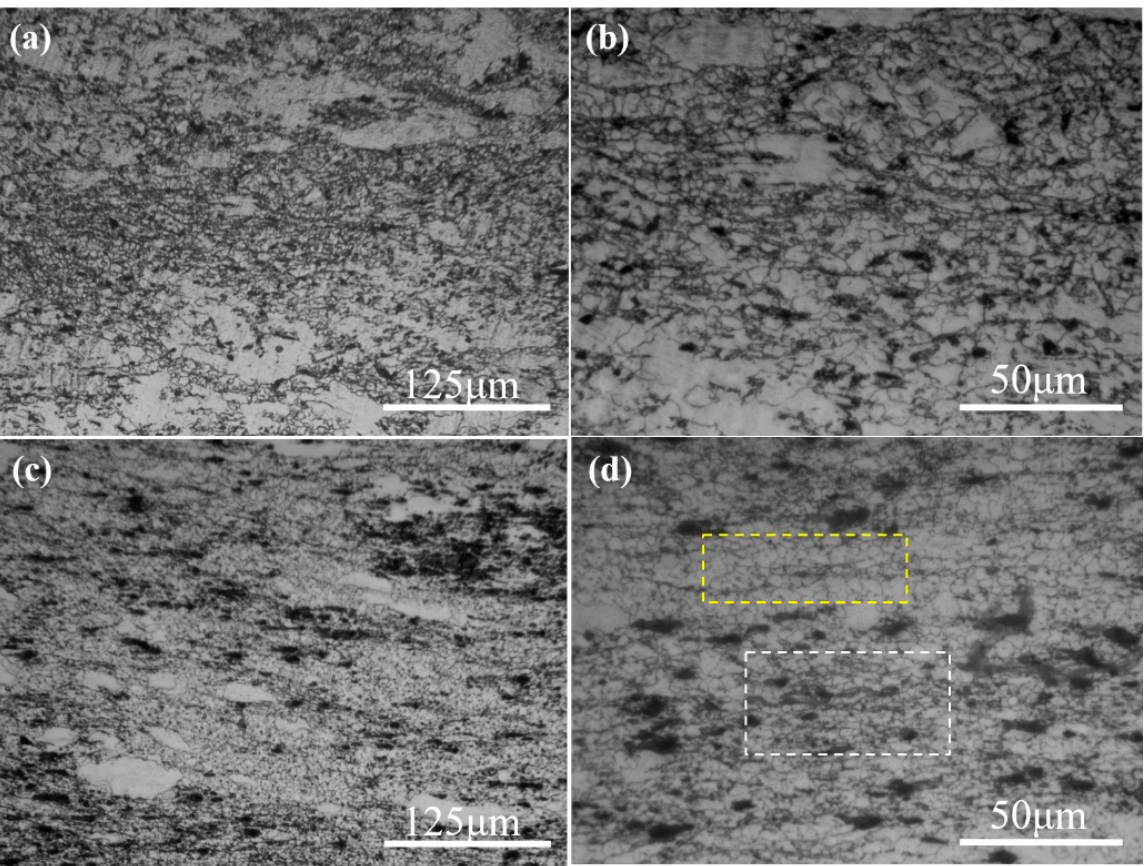
Figure 8. OM microstructures of the SiC p /Mg-5Zn material with compression strains of ( a , b ) 0.35 and ( c , d ) 0.7, the yellow box in ( d ) is the area away from particles and the white box in ( d ) is the area near the particles.